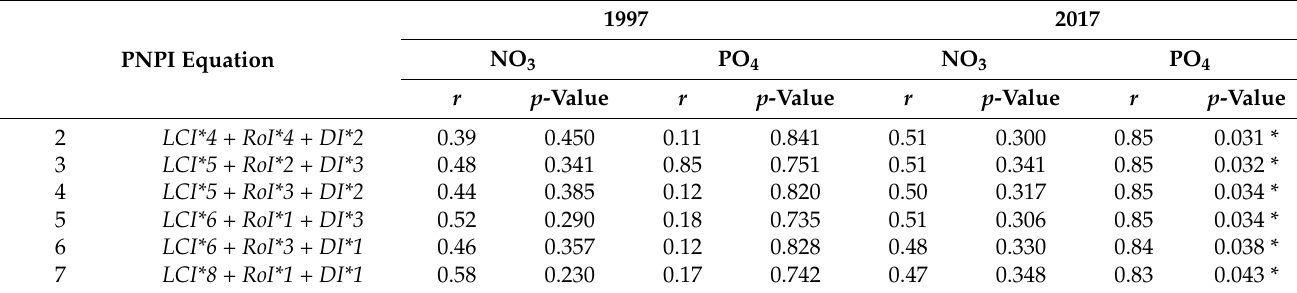
Table 10. Pearson coefficient of correlation (r) between non-point pollution index (PNPI) calculated using Equations (2)–(7) and measured mean nitrate (NO 3 ) and phosphate (PO 4 ) concentrations in outlets of the six sub-catchments in 1997 and 2017.